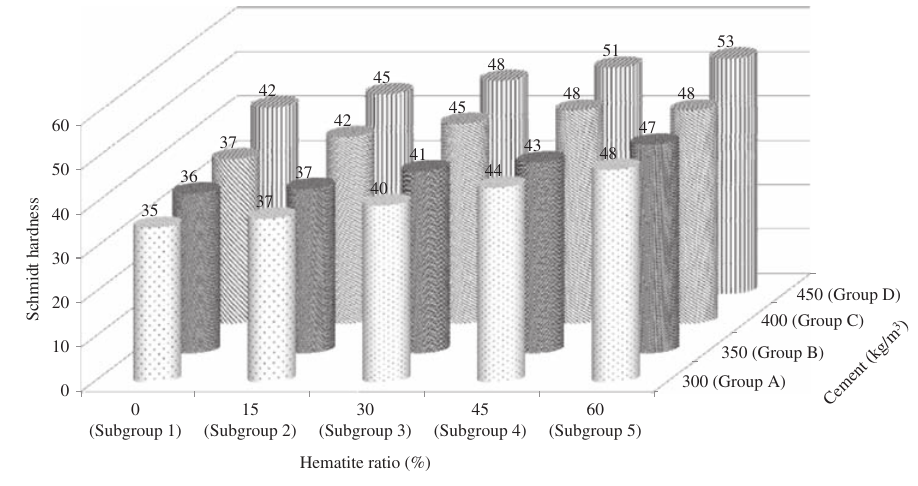
Figure 8 Schmidt hardness of concretes.